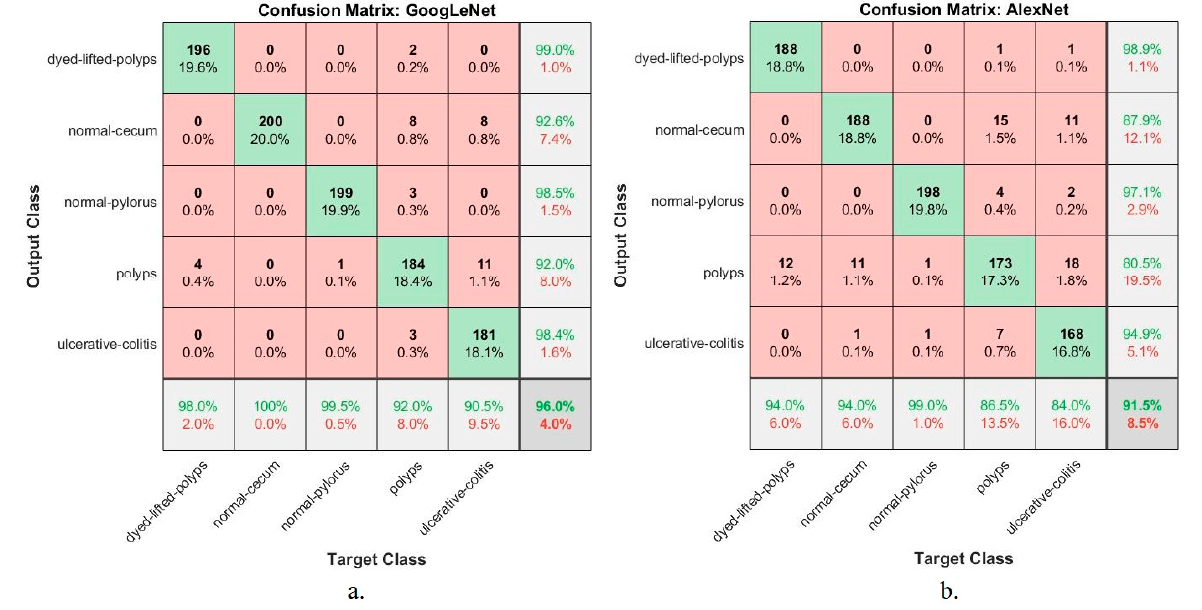
Figure 19. Confusion matrix for the lower GI dataset generated by using ( a ) GoogLeNet ( b ) AlexNet.